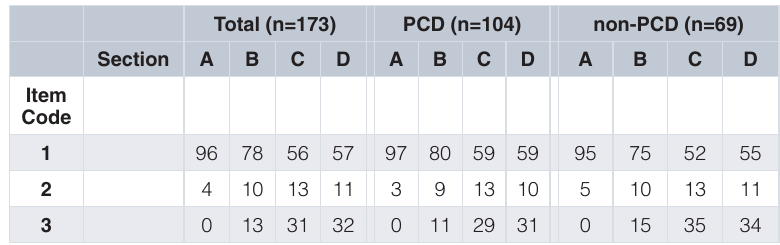
Table 1. Initial Completion rate of various questionnaire sections. Item codes: 1=completed, 2=not completed yet item relevant, 3=not completed and item not